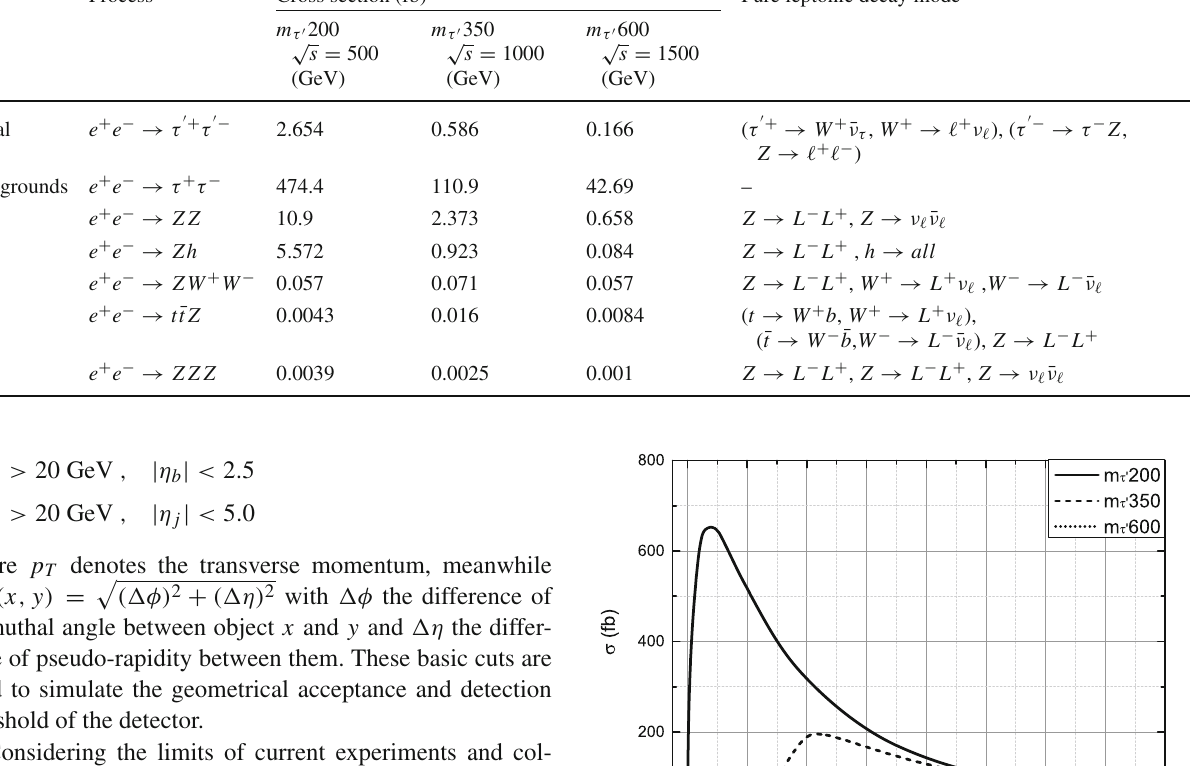
Table 2 The processes and cross sections of the signal and backgrounds for three benchmark points in pure leptonic channel, where L ± = (cid:10) ± ,τ ± . The conjugate processes of the signal and backgrounds have been considered Process Cross section (fb) Pure leptonic decay mode